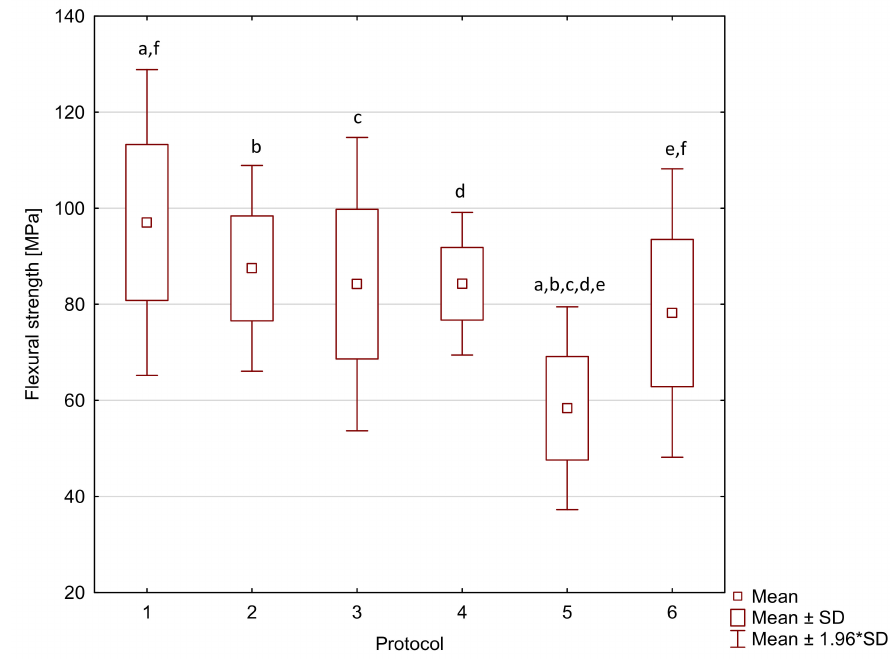
Figure A4. Box-and-whisker plot of three-point bending flexural strength (FS) of Flow-Art material. Statistically-significant differences were detected between the following: (a,b,c,d,e) Protocol 5 (0.1 M NaOH, 7 days, 60 ◦ C) vs. (a) Protocol 1 (water, 24 h, 37 ◦ C) ( p = 0.000003); (b) Protocol 2 (artificial saliva, 90 days, 37 ◦ C) ( p = 0.000194); (c) Protocol 3 (water, 500 thermocycles, 5/55 ◦ C) ( p = 0.000756); (d) Protocol 4 (water, 7500 thermocycles, 5/55 ◦ C) ( p = 0.000730); (e) Protocol 6 (water, 5 days, 55 ◦ C)